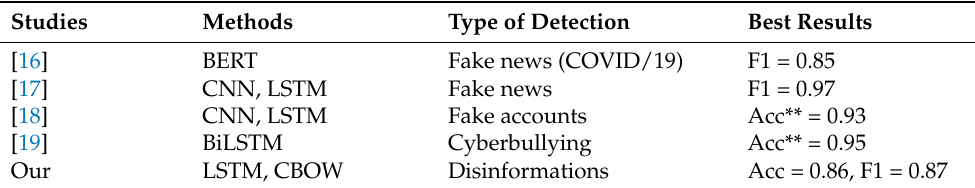
Table 8. Comparison of results our best model to the best models from previous studies focused on the same respectively similar problem.